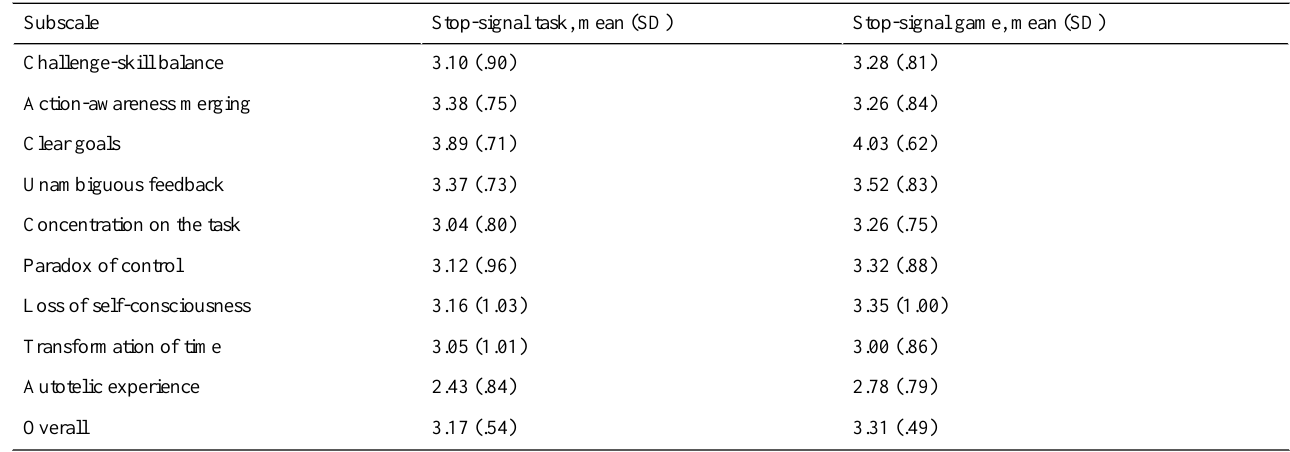
Table 4. Mean scale values for each Flow subscale depending on the task variant for study